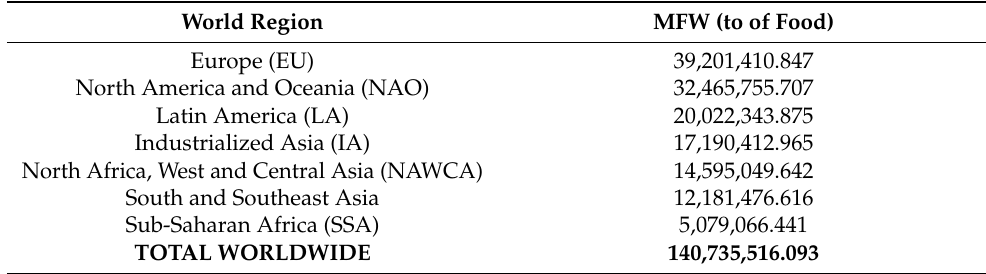
Table 1. Metabolic Food Waste MFW (tons of food) associated with overweight and obesity—authors’ selection after